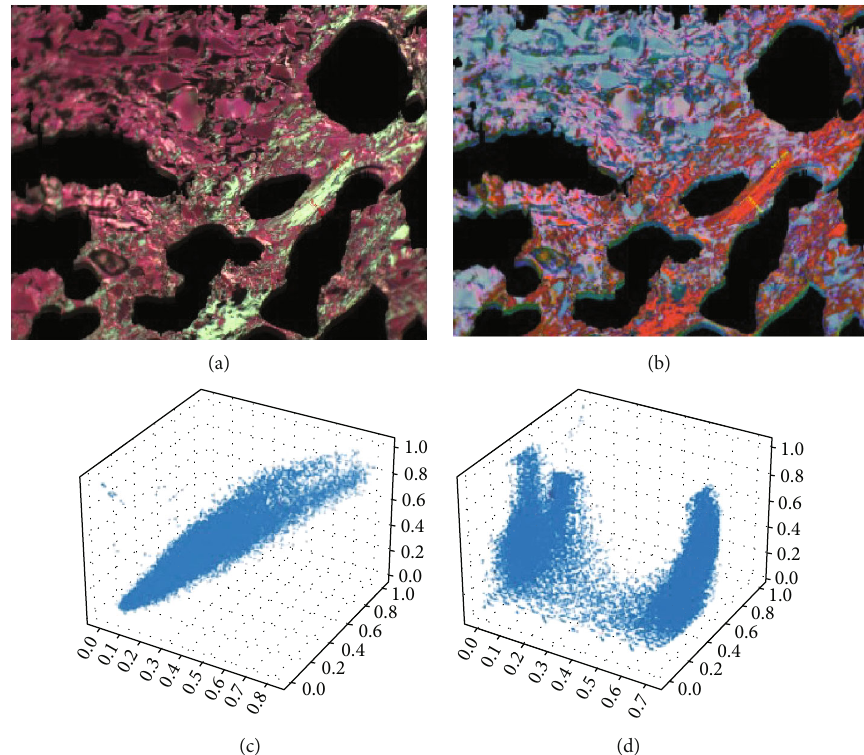
Figure 11: Color space transformation: (a) pixels of the main body in RGB space; (b) pixels of the main body in HSV space; (c) normalized scatter plot of pixels of the main body in RGB space; (d) normalized scatter plot of pixels of the main body in HSV